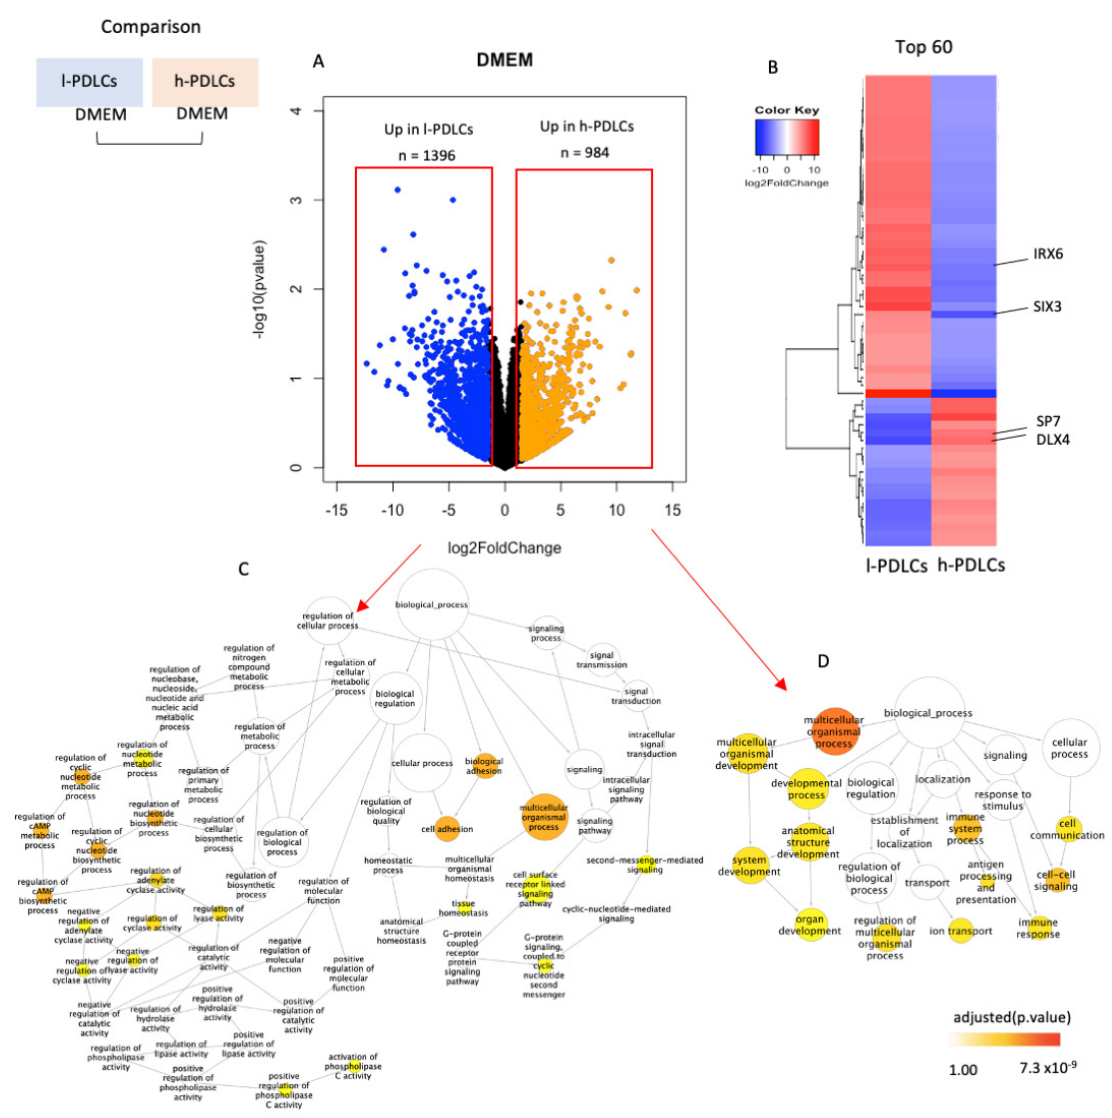
Figure 2. Transcriptional regulation in unstimulated PDLCs with distinct osteogenic potential. RNA- seq data were compared between l- and h-PDLCs cultured in standard DMEM. ( A ) Differential gene expression between the two populations as determined by log2FoldChange. ( B ) The top 60 most differentially expressed genes are shown as a heatmap, highlighting IRX6 , SIX3 , SP7 and DLX4 genes (red—upregulation; blue—downregulation). ( C , D ) Biological processes related to genes upregulated in l-PDLCs ( C ) and in h-PDLCs ( D ) were identified using the Gene Ontology Consortium software followed by the removal of redundant terms using REVIGO. l-PDLCs, periodontal ligament cells showing low osteogenic potential in vitro; h-PDLCs, periodontal ligament cells showing high osteogenic potential in vitro .